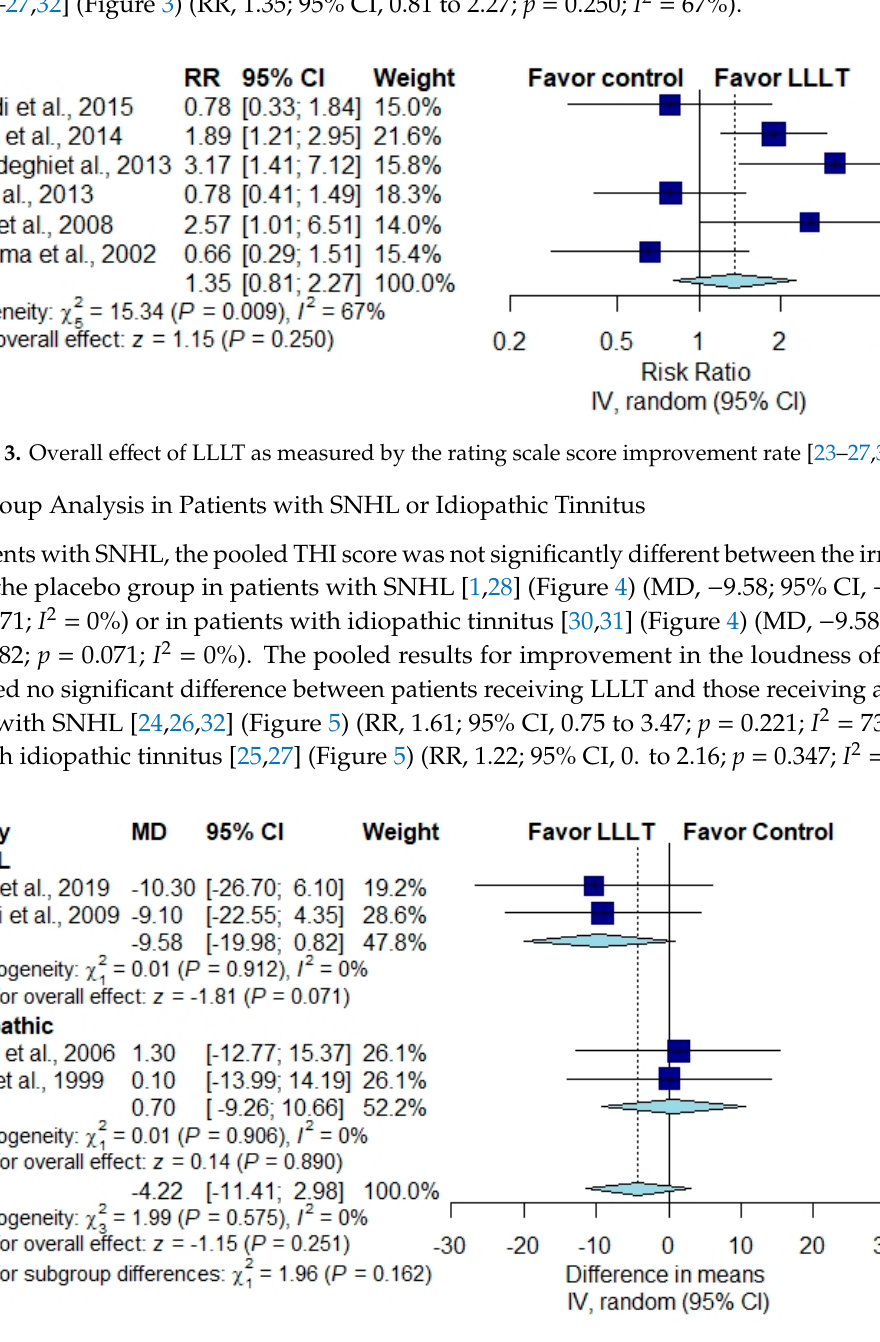
Figure 2. Overall effect of low ‐ level laser therapy (LLLT) as measured by the THI score [1,28–31].